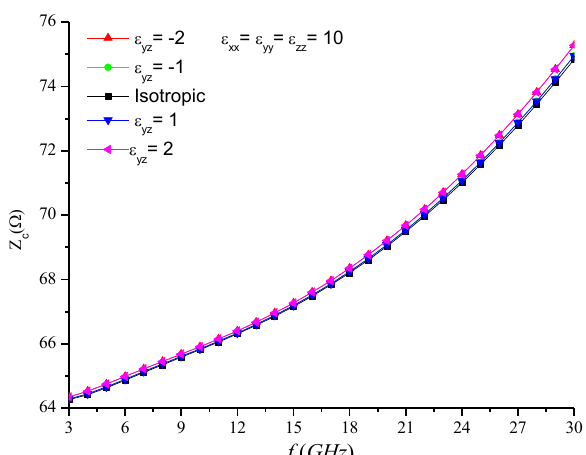
Figure 7.b: Effect of real valued e yz on the characteristic impedance